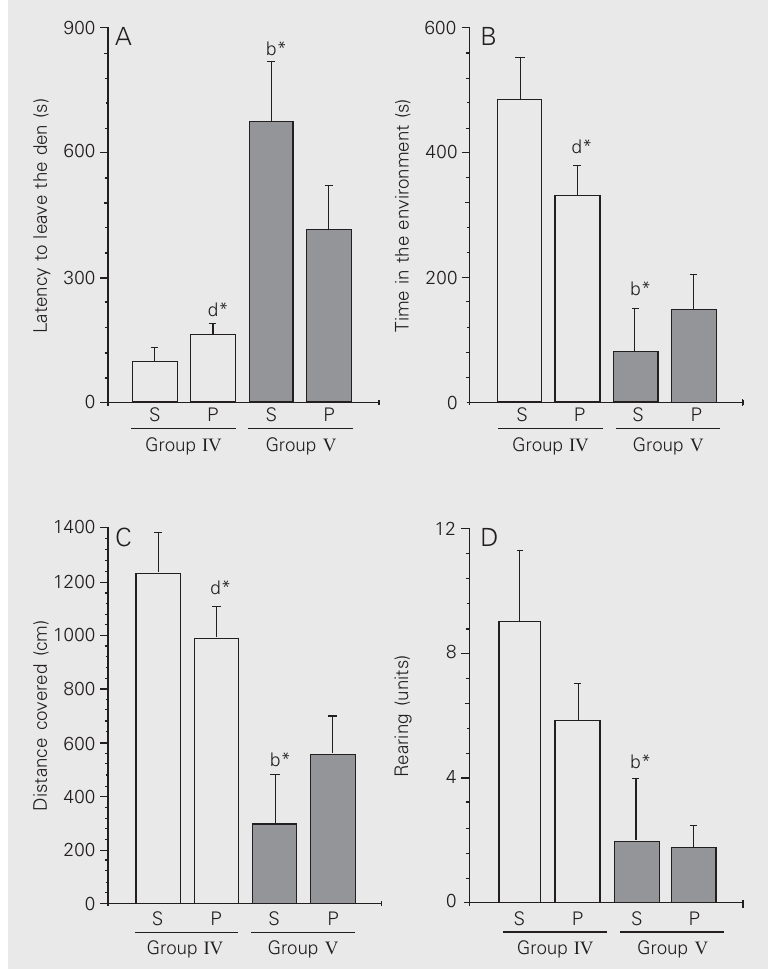
Figure 1. Behaviors studied in the exploratory tests applied to grouped (IV) or isolated (V) animals submitted to 30 min of adaptation to specific conditions (grouped or isolated) and then to 15 min of effective exploratory test. A , Latency to leave the den; B , time in the environment; C , distance covered; D , rearing. Both groups (collective - IV and isolated - V) were divided into two subgroups (“S” - most stressed animal in the cage, and “P” - the other two animals in the cage). Significant differences were observed between group IV/S and V/S (b) and group IV/P and V/S (d) (*P < 0.05, ANOVA). The number of animals was 6 for subgroup “S” and 12 for subgroup “P”, both for groups IV and